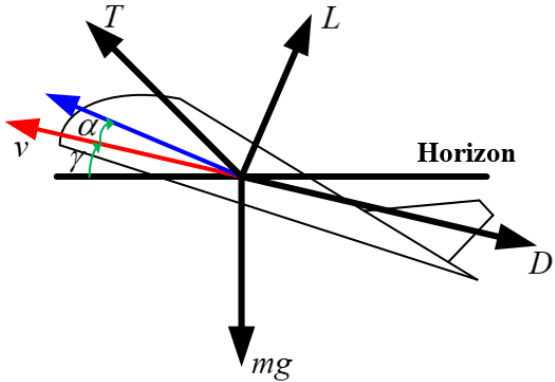
Figure 3. Force analysis of electric propulsion UAV during climbing flight.